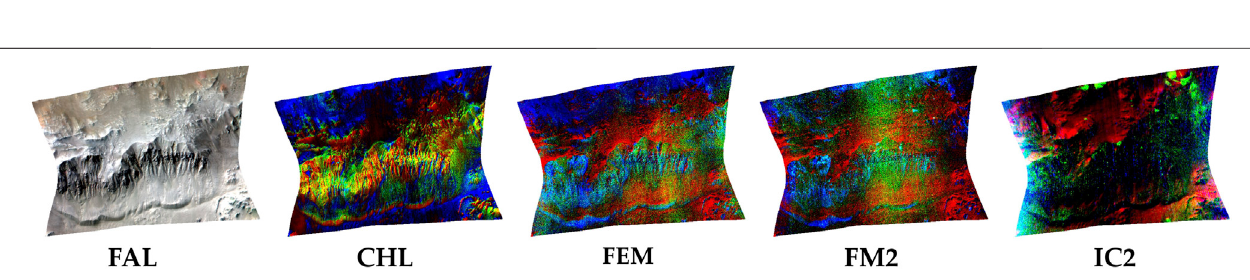
FIGURE 12 | CRISM Browse products results in Eastern Hale Crater. Footprints of data are shown with red polygons in Figure 3 .